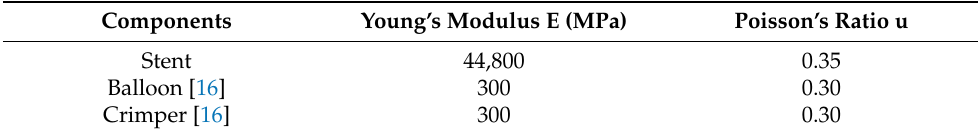
Figure 1. Tensile stress–strain curve for a Mg alloy (AZ31B). Table 1. Mechanical properties of components.